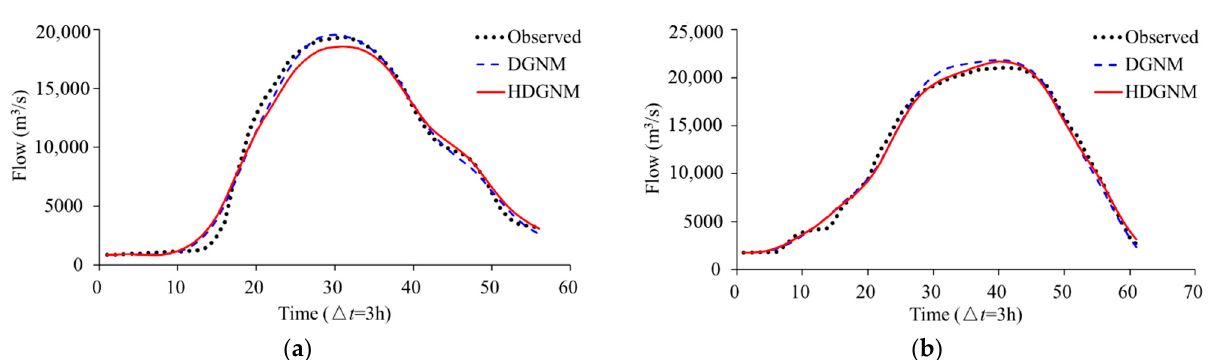
Table 1. Accuracy evaluation results of DGNM and